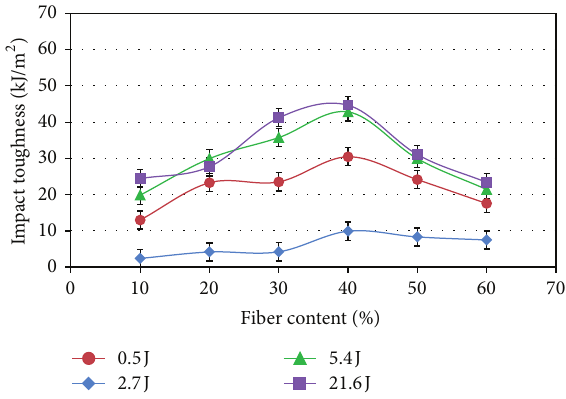
Figure 11: Effect of fiber content on impact toughness of kenaf/PVB composites.